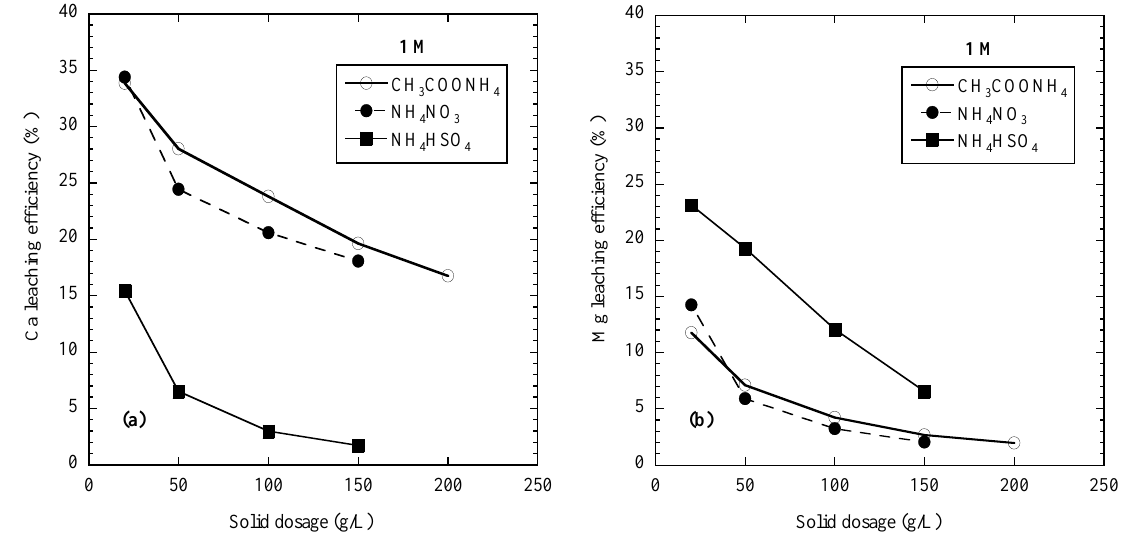
Figure 3. Ca and Mg-leaching efficiencies as a function of the solid dosage with the 1.0 M ammonium solution for waste slate samples.